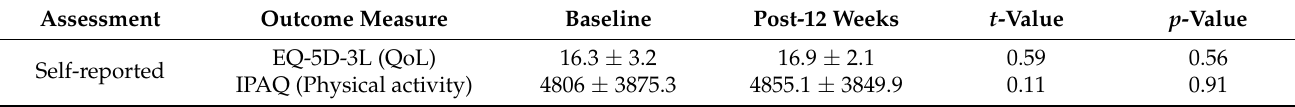
Table 4. Changes in self-reported measures ( n =